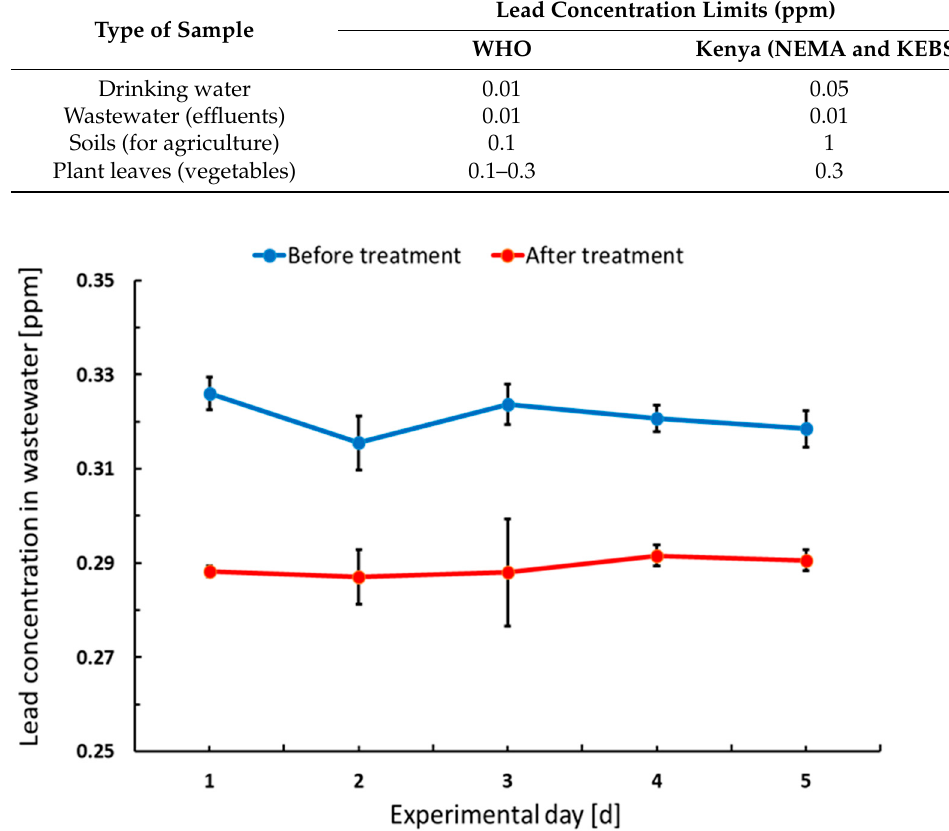
Figure 3. Mean variation in lead concentration in effluent over 5 days from the measurements of factory operations before treatment and after NaCO 3 treatment in